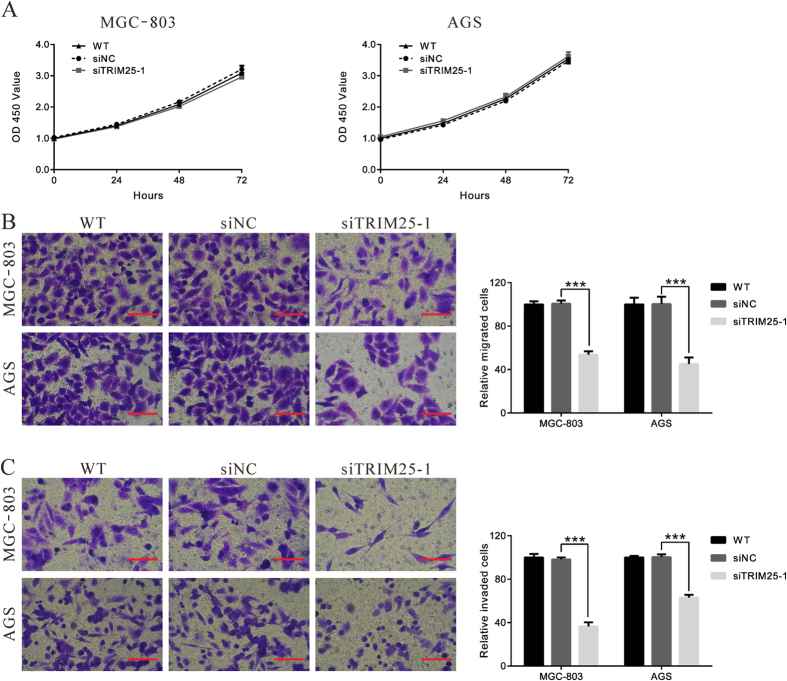
Reduced expression of TRIM25 suppressed the migration and invasion of GC cells.(A) Cell proliferation was detected in MGC-803 and AGS cells by CCK-8 assay. (B) Migration of MGC-803 and AGS cells treated with TRIM25 siRNA-1 or control siRNA was checked using no-matrigel coated transwell chamber. (C) Invasive ability of MGC-803 and AGS cells treated with TRIM25 siRNA-1 or control siRNA was assessed by using matrigel-coated transwell chamber. Scale bar: 100 μm. WT: wild type cells; siNC: scrambled siRNA-transfected cells; siTRIM25-1: TRIM25-siRNA-1-transfected cells (***P < 0.01).